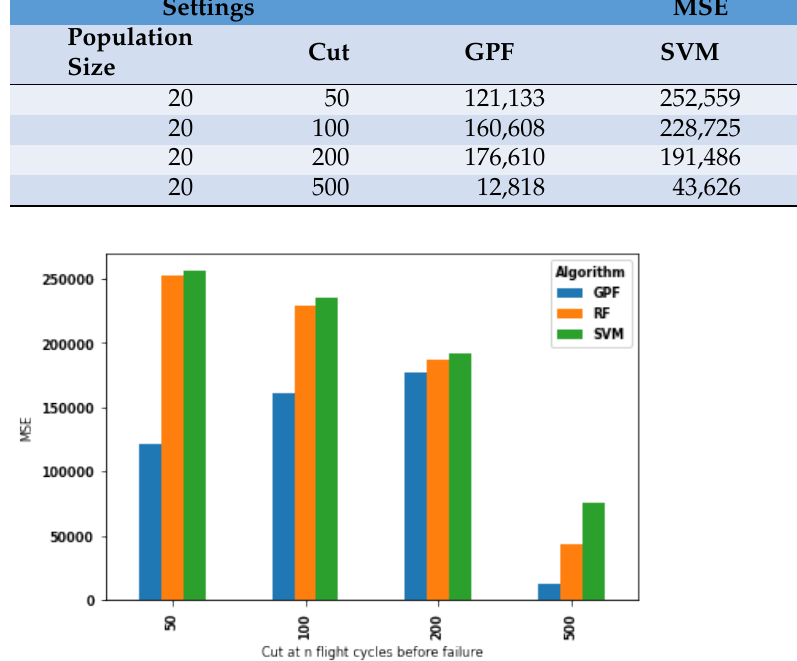
Figure 15. MSE of using GPF, only RF or SVM for different cut settings (cut 50, 100, 200, or 500 FC before failure).